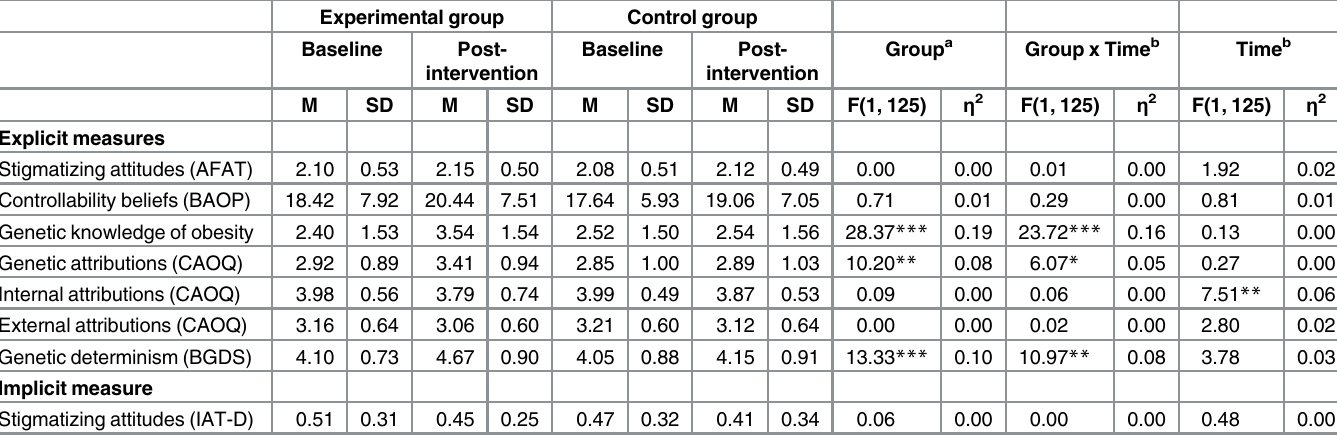
Table 2. Study 2: Effects of a brief interactive stigma reduction intervention over four weeks in a general population sample (N =